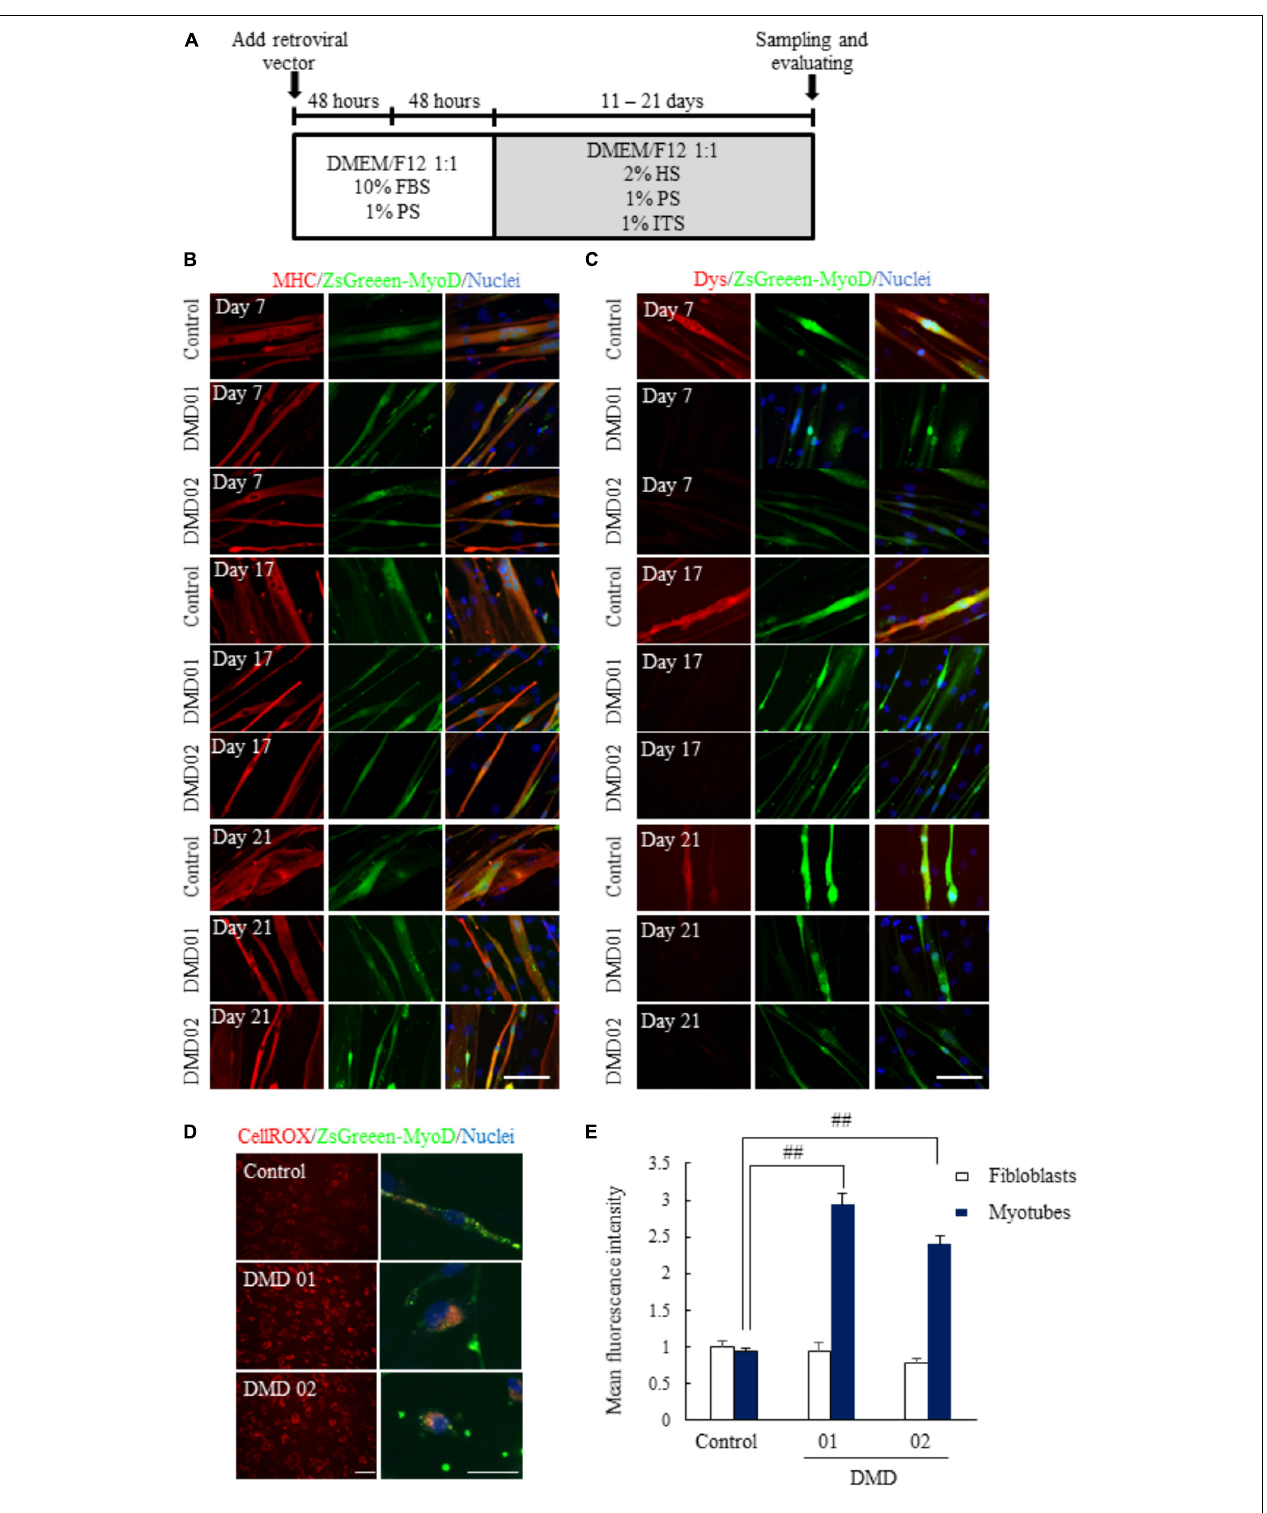
FIGURE 2 | Conversion of fibroblasts to myotubes by MyoD transduction. (A) Schematic of myotubes differentiation from MyoD-transduced fibroblasts. (B) Immunostaining of skeletal muscle marker (myosin heavy chain, MHC) 11 to 21 days after myogenic differentiation. (C) Immunostaining of dystrophin 11 to 21 days after myogenic differentiation. The myotubes from MyoD-transduced fibroblasts of DMD patient resulted in the decrease of dystrophin protein. Scale bar = 50 µ m. (D,E) ROS assay using CellROX R (cid:13) deep red reagent to investigate whether ROS production was promoted or not. Data are shown as means ± SEM ( n = 5). ## p < 0.01 vs. Control (Student’s t -test). Scale bar = 100 µ m (left image), 50 µ m (Right magnified image).